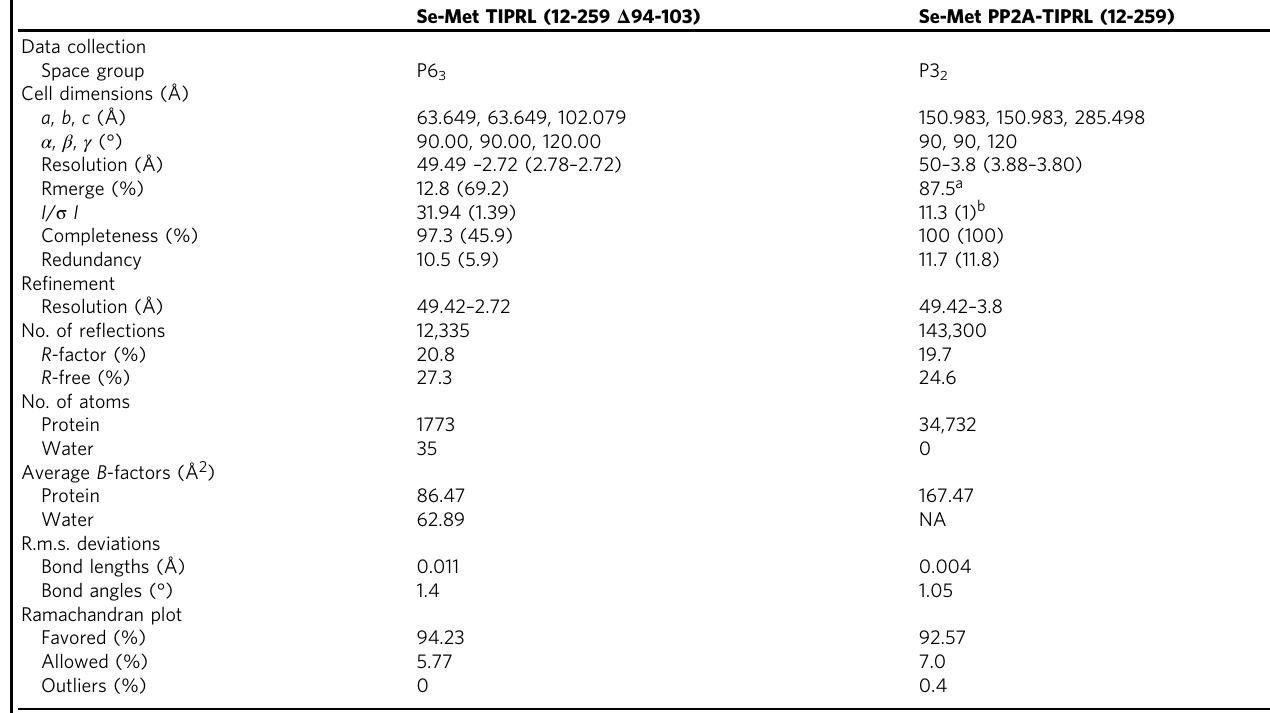
Table 1 Crystallographic data collection and re fi nement statistics Se-Met TIPRL (12-259 Δ 94-103) Se-Met PP2A-TIPRL (12-259) Data collection Space